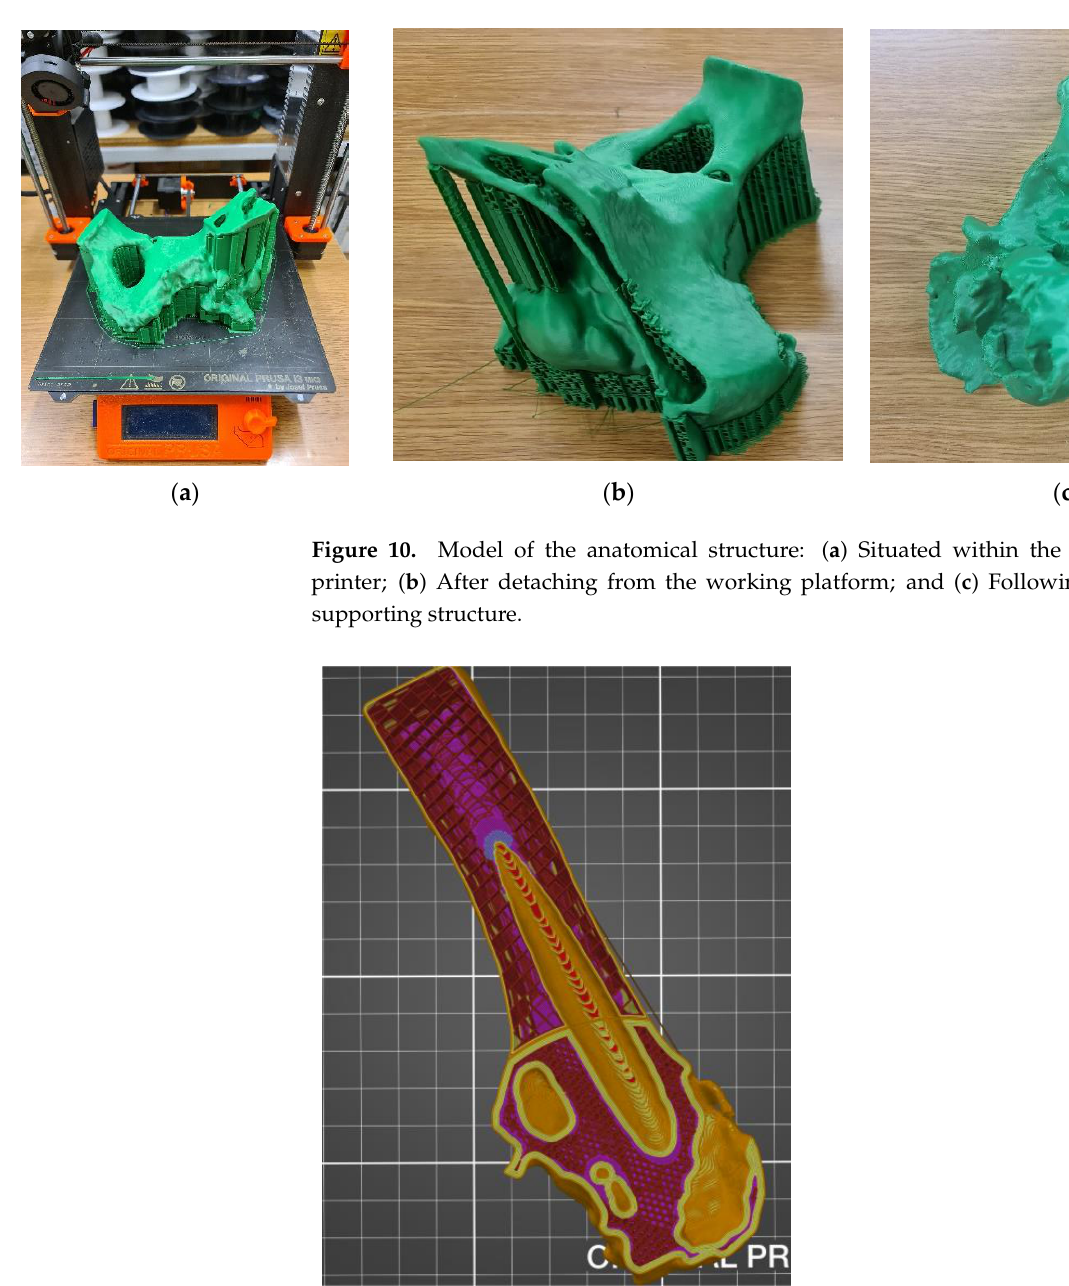
Figure 12. View of the anatomical model of the part of the bone in the working space of the software. For testing both solutions, 3D prints of the hip joint model with a part of the femur for Patient No. 7 were performed in two ways. The first one consisted of making a single bone cement model together with the pelvic bone (Figure 13a) and the upper part of the femur (Figure 13b). ( a ) ( b ) Figure 13. Model of the anatomical structure: ( a ) Part of the bone of the pelvis with the bone cement, and ( b ) the upper part of the femoral bone.